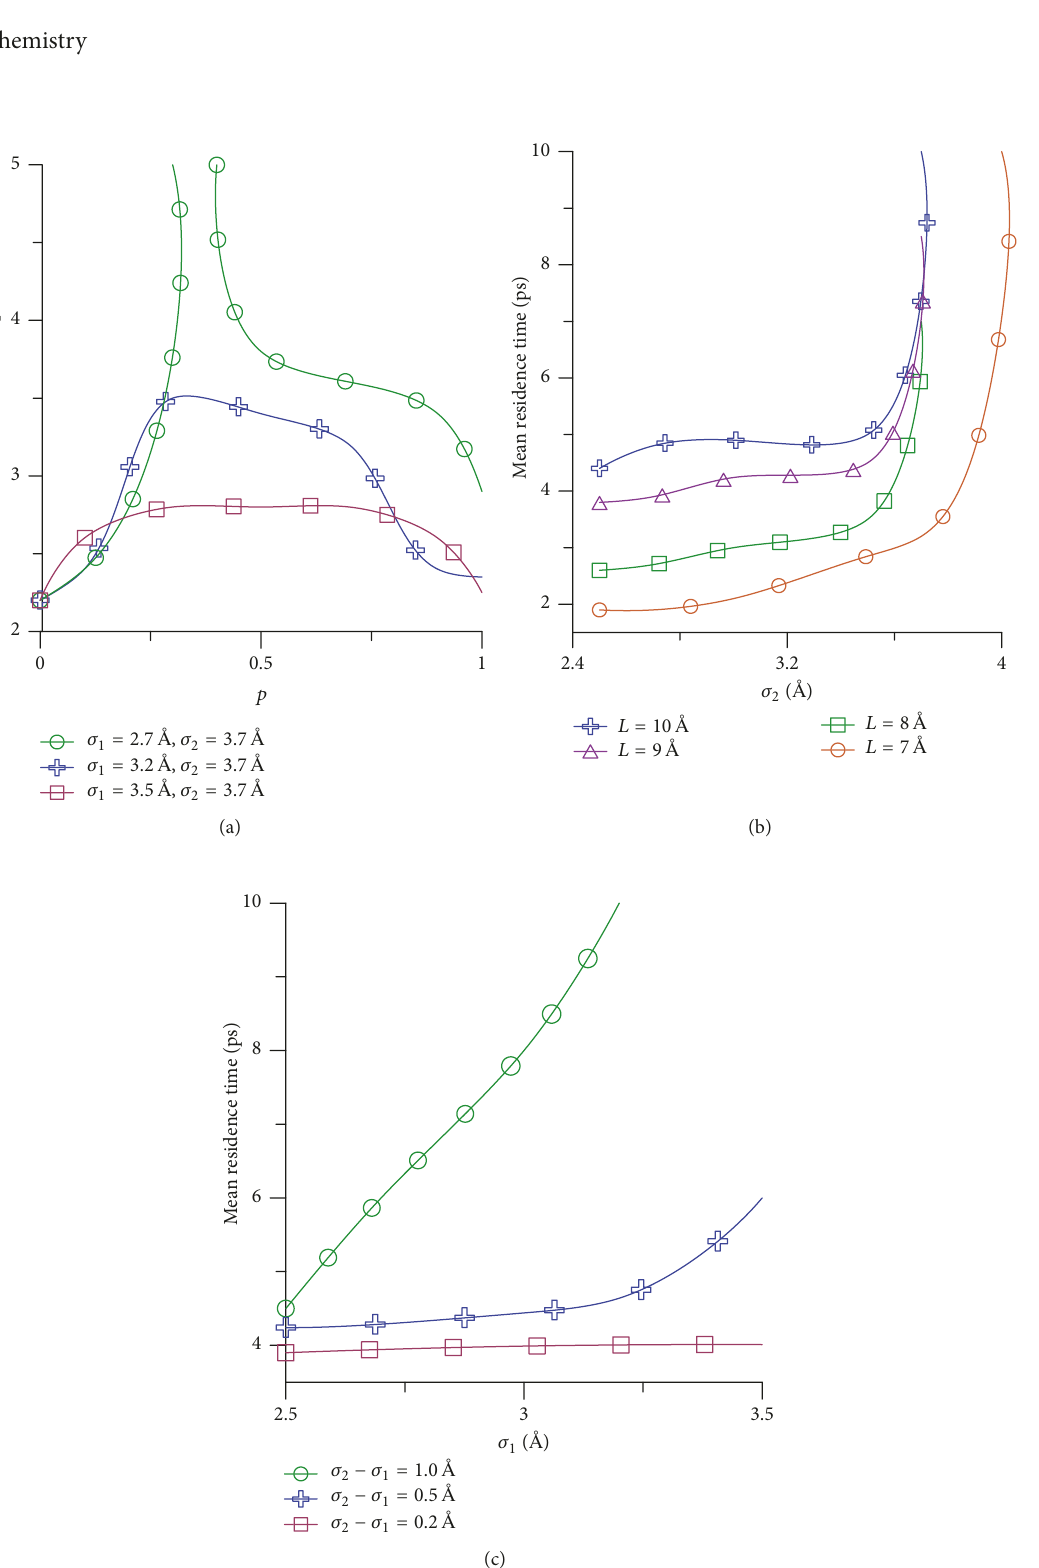
𝜎 𝜀 1 (each 1 with the corresponding 1 ) for linear